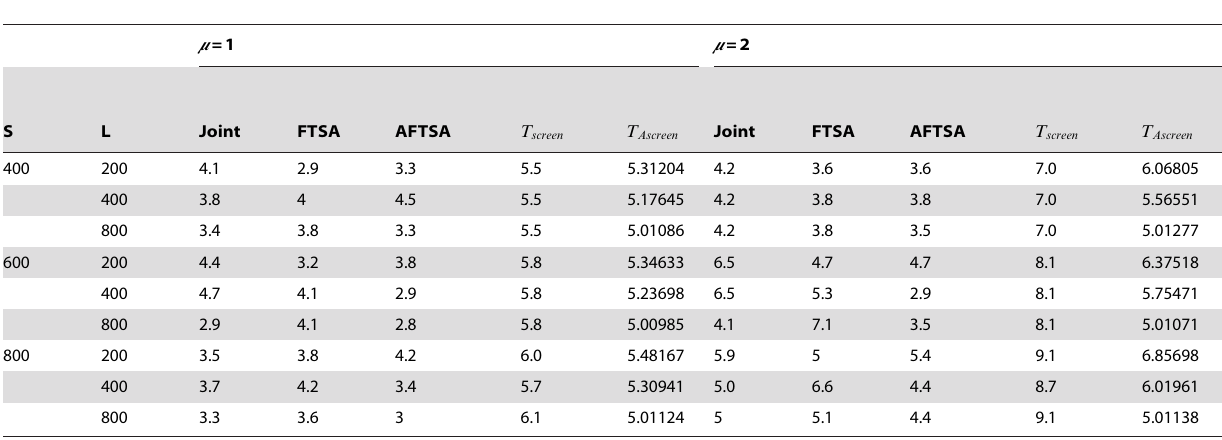
Table 3. Type I error rates (in percentage) of the five tests based on simulation set 3.